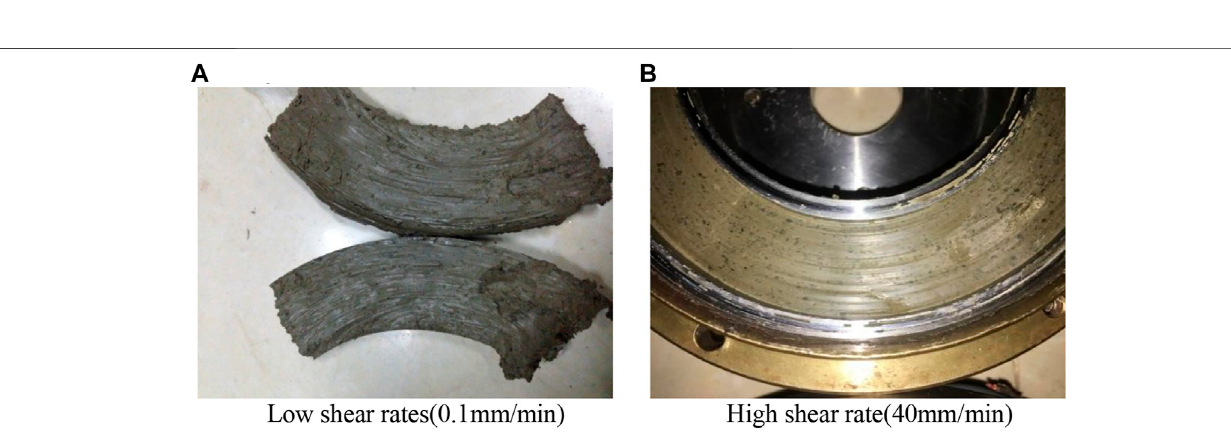
Frontiers in Earth Science |